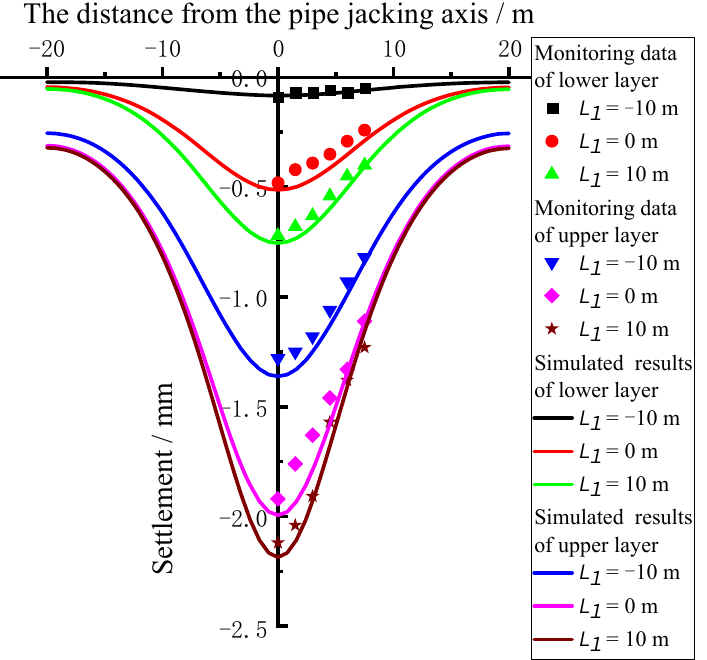
Figure 10. Ground settlement comparisons at different jacking locations.